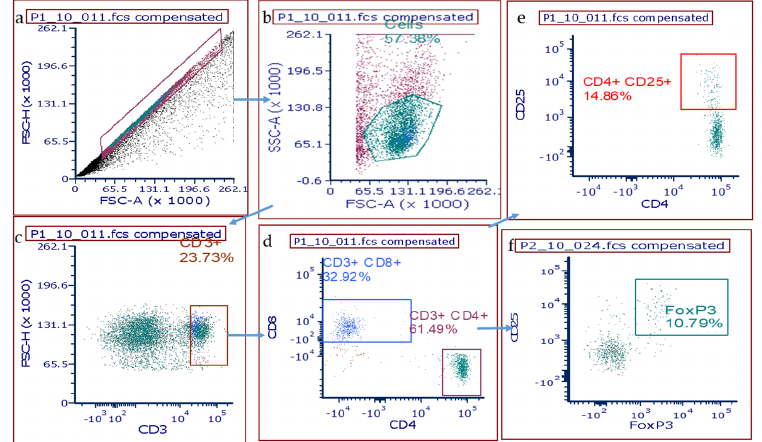
Figure 3. Gating scheme for T cell isolation and identification from whole rat lung homogenates. ( a ) Total isolated cells were first gated for singlets on FSC − A versus (vs.) FSC − H, then ( b ) SSC − A vs. FSC − A to exclude debris and followed by ( c ) CD3 + cells vs. FSC − H. ( d ) Sub-gating for CD8+ or CD4+ sub-populations was then applied, and then further gated for CD25+ ( e ) and FoxP3+ T cell populations ( f ).